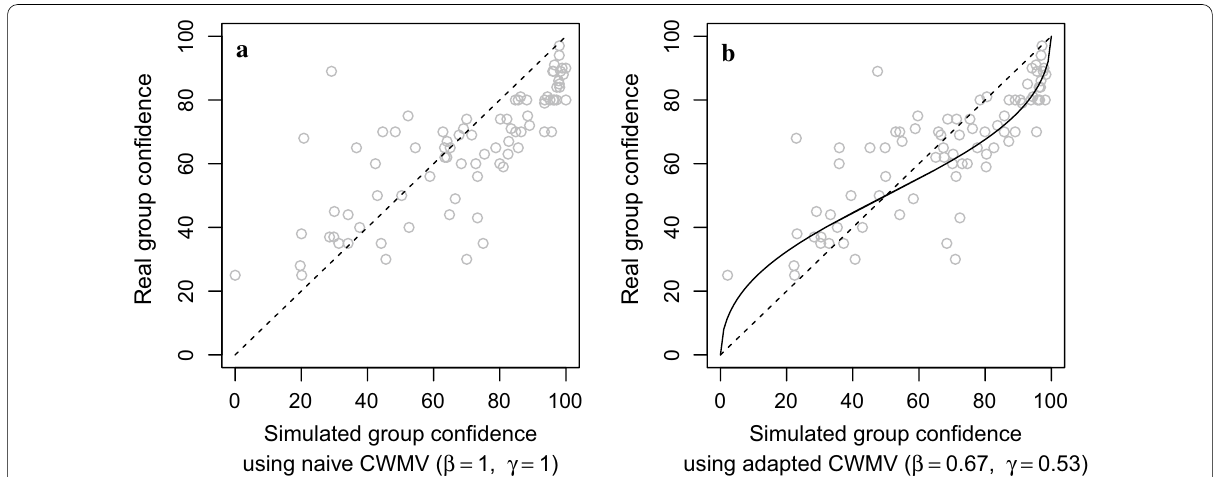
Fig. 4 Comparing real versus simulated group responses from statistically aggregating individual responses. We used individual responses to simulate group confidences via CWMV ( x -axis). These simulations predict responses from real, interacting groups ( y -axis). In a , we used naive CWMV as in Eqs. 1 and 2. The dashed line represents predictions from naive CWMV. This is equivalent to our formal cognitive modeling with equality effect β = 1 and group confidence effect γ = 1 . In b , we estimated the equality effect, β = 0.67 , and group confidence effect, γ = 0.53 , see Eqs. 3 and 4. This model predicts real group responses (solid line) but incorporates the fact that real groups treated individual votes more equal and displayed an underconfidence effect. In both subfigures, confidence ratings are inverted for incorrect responses. For example, the point (34%, 35%) in a corresponds to a trial with a simulated confidence of 66% and a reported confidence of 65% with both decisions being the same but incorrect; hence, both confidences were